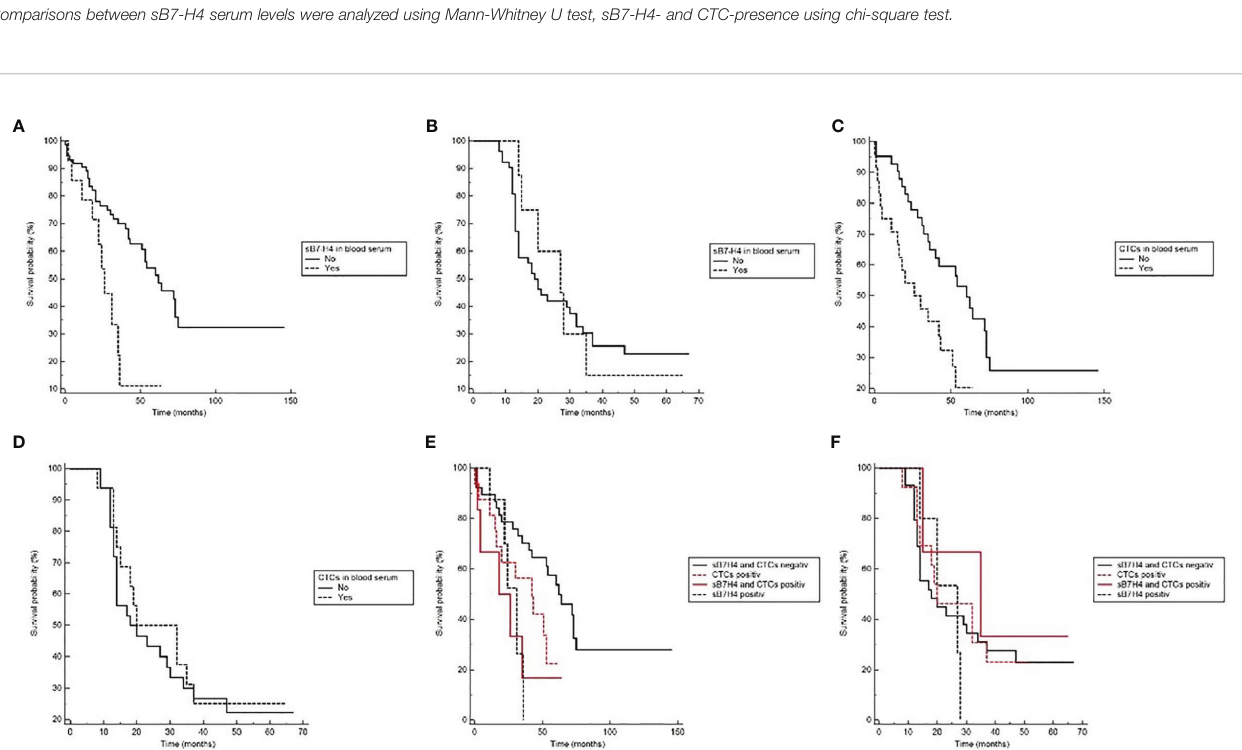
TABLE 2 | Associations of sB7-H4 blood serum levels, sB7-H4 presence in serum and CTCs to clinicopathological parameters. Total n = 85 sB7-H4 ng/mL levels FIGO stage III